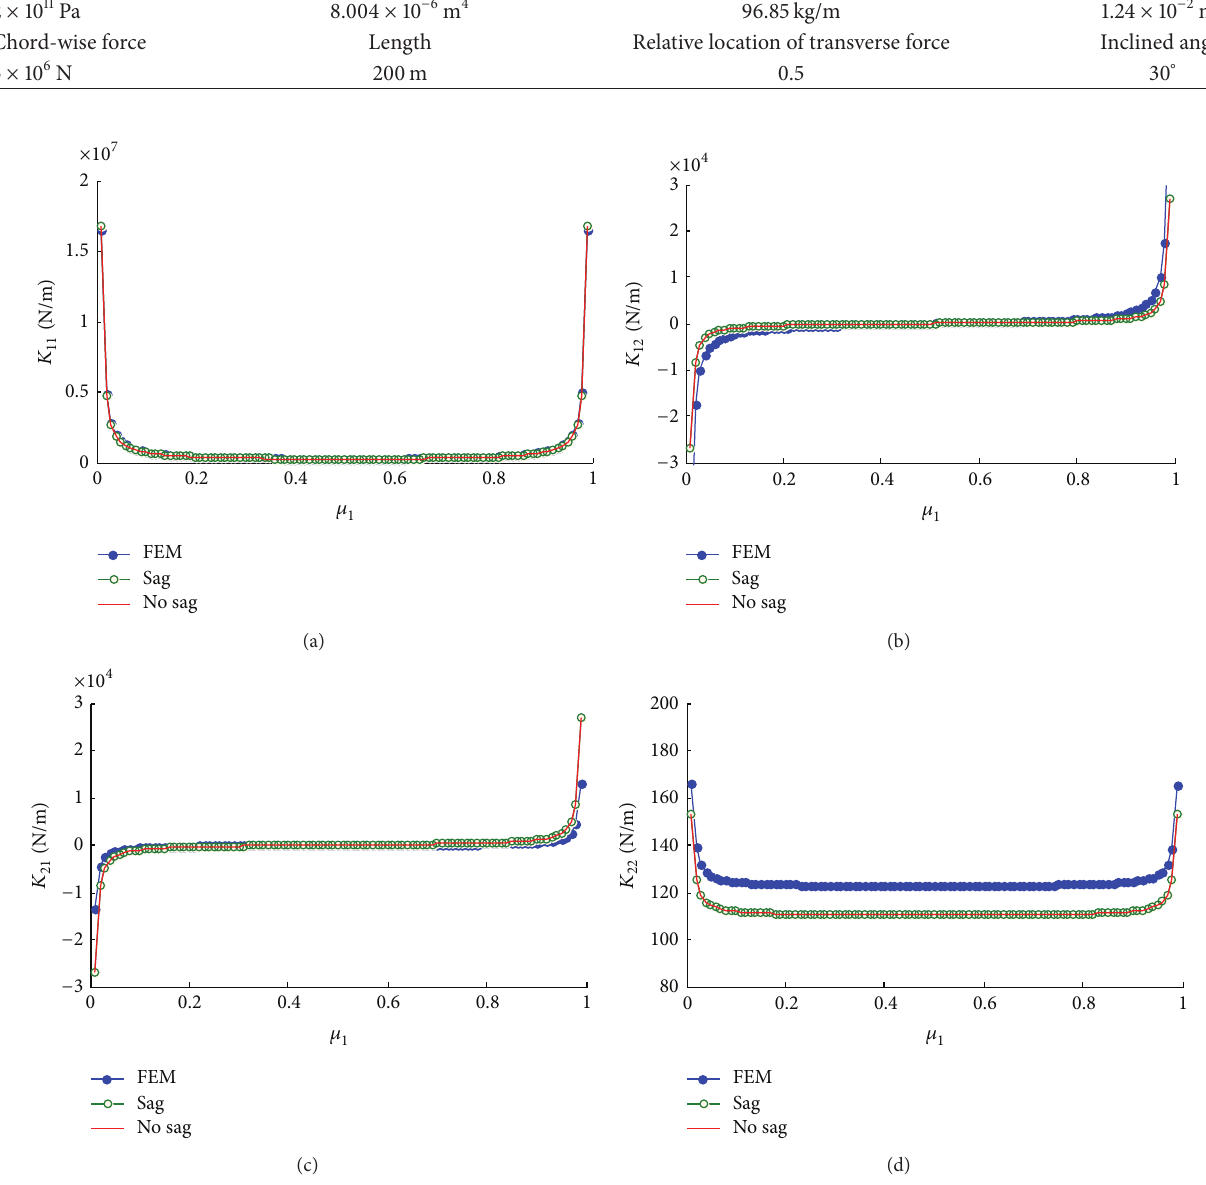
Figure 4: Comparison of the terms of the static stiffness matrix along the length of cable with two transverse degrees of freedom using the three presented methods ( 𝜔 = 0 , unit: